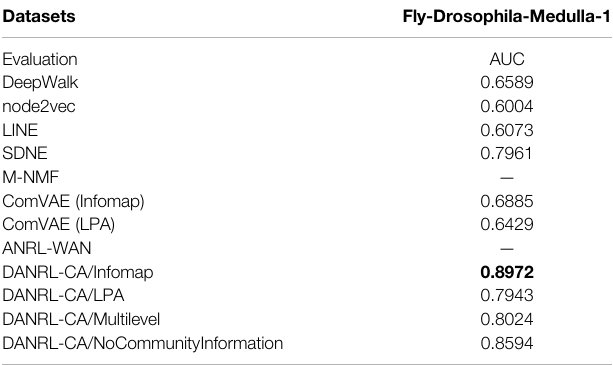
TABLE 11 | Link prediction results on Fly-drosophila-medulla-1 dataset.